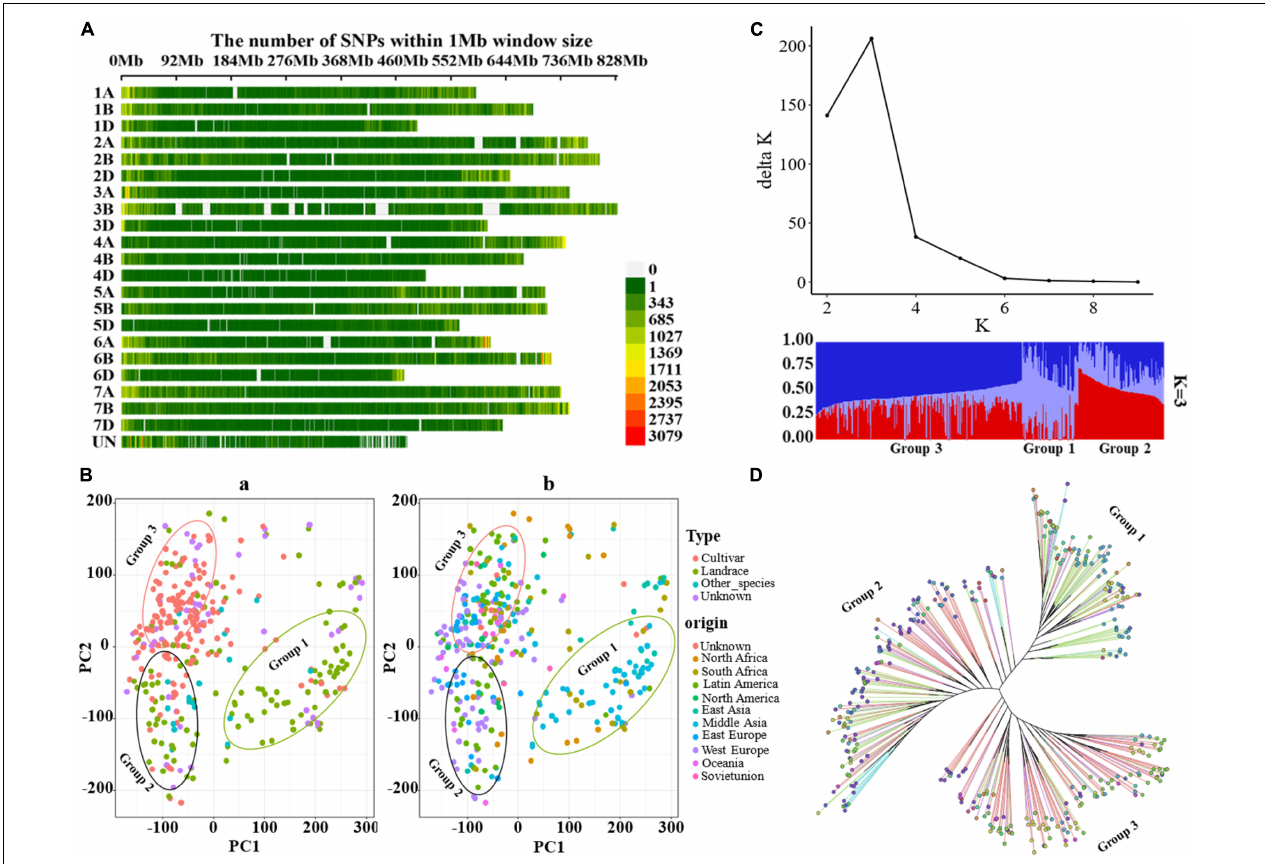
FIGURE 1 | Genotypic features and population structure of bread wheat. (A) The distribution of SNPs across the entire genome, the color legend indicates the SNP number. (B) Principal component analysis (PCA) across the 352 wheat accessions, the color legend “Type” is for [ (B) a], “Other_species” is for the relatives (19 accessions) of T. aestivum , “Unknown” is for missing record for cultivar or landrace, the color legend “origin” is for [ (B) b], “Unknown” is for missing record of origin. (C) Population structure for 352 accessions, the optimal cluster (K) was K = 3. (D) Maximum-likelihood tree constructed with IQ-tree, (D) shared the same color legend with (B) , and the color legends “Type” and “origin” refer to the branches and the nodes at the end of the branches in the tree, respectively.